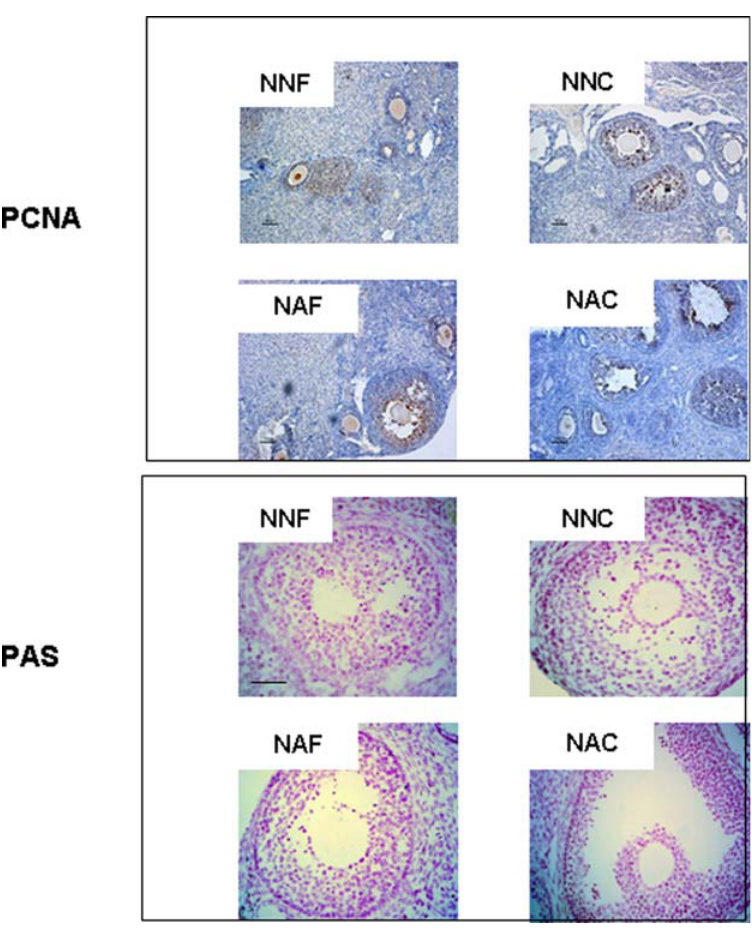
Figure 2.Follicular proliferation and apoptosis. Cell proliferation was studied using PCNA antibody and apoptosis using PAS staining one month after grafting. Immature ovarian cortex was grafted in non-mature mice freshly (NNF) or after cryopreservation (NNC) or in adult mice freshly (NNF) or after cryopreservation (NNC). All images are at the same magnification. Scale bar, 50 m m